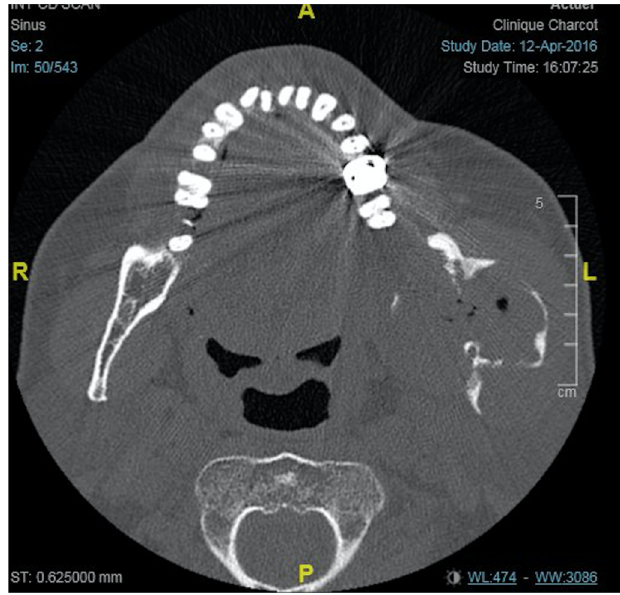
Fig. 3. Scan of facial bone window and in axial section at the mandibular level, at 5 years, showing an osteolytic and expansive lesion of the ascending branch of the left mandible.